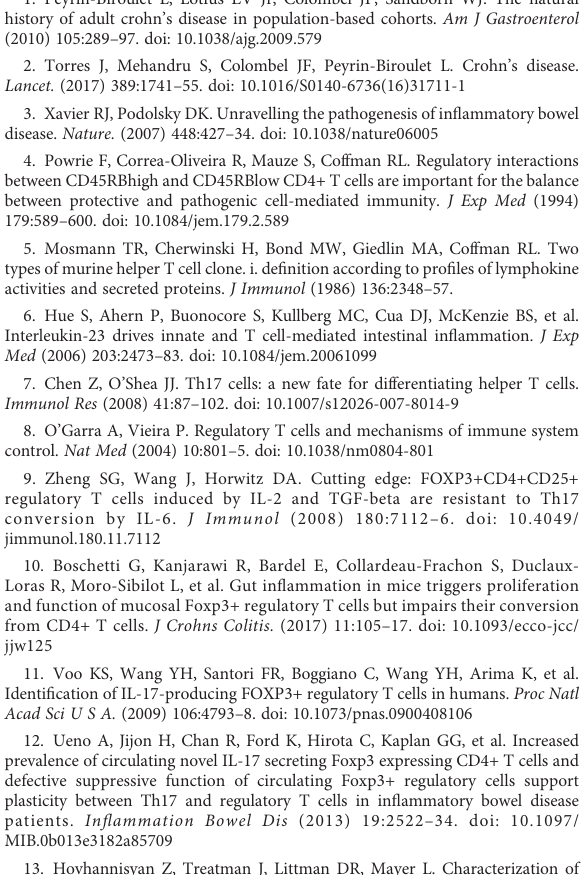
SUPPLEMENTARY FIGURE 1 Gatingstrategy.Amongthetotalleucocytes,doubletscells,deadcellsand debris were excluded based on SSC or FSC characteristics. Cell population were gating on CD3 + cells. CD4 + cells were gated on CD3 + . IL17A, IFN g and Foxp3 were evaluated among CD4 + populations (A) . Then AmongFOXP3+cells,IL17AandIFN g positivecellsweregating (B)